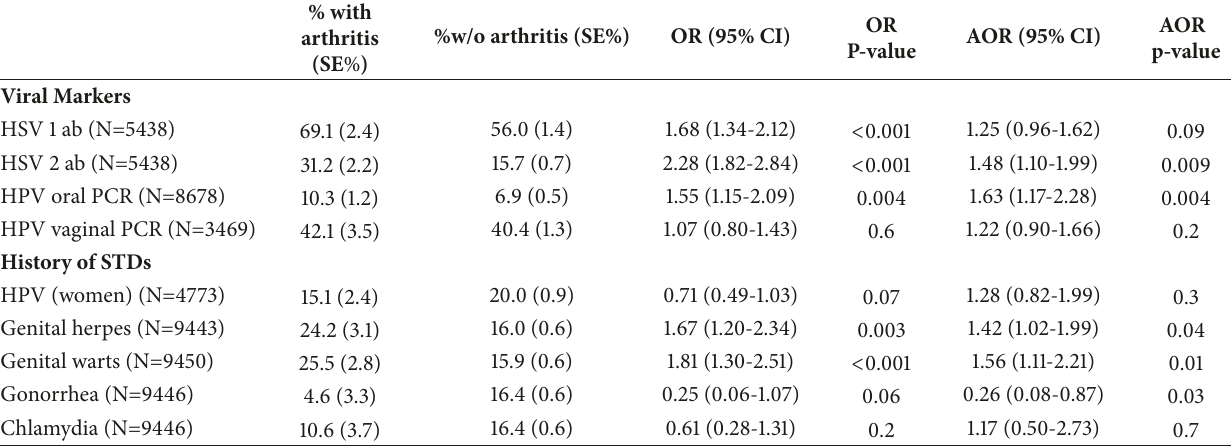
Table 2: Associations of viral markers and sexually transmitted diseases with self-reported arthritis, US adults ages 20-69 (N = 9483). % with